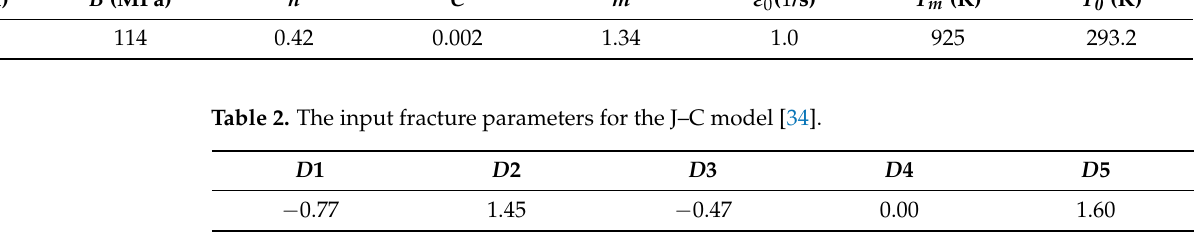
Table 1. The J–C material model parameters [34].